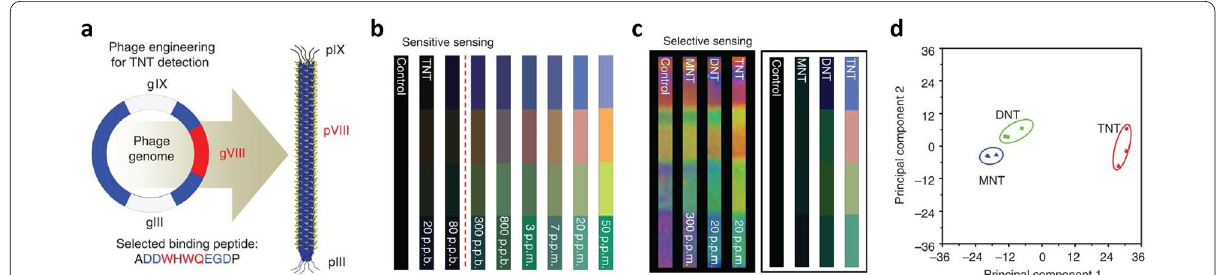
Fig. 5 Specific target detection using genetically engineered M13 bacteriophage. a 2700 copies of the TNT‑binding receptor (WHWQ) identified by directed evolution which are genetically engineered onto the surface of M13 bacteriophage. b Detection sensitivity of colour band regarding TNT. The dashed red line indicates the sensitivity limit against TNT. c Photos and processed colour fingerprints of colour band after TNT, DNT, and MNT exposure. d Principal component analysis (PCA) plot of the colour changes resulting from the exposure of the Phage litmus to TNT, DNT, and MNT ( a – d Reproduced with permission from Ref. [54]. Copyright 2014, Nature Publishing